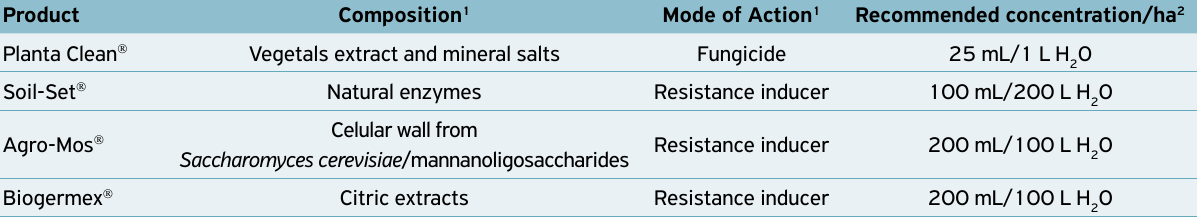
Table 1. Alternate phytosanitary products, mode of action and recommended concentration, used to evaluate the effect of the products on the development and silk production of B. mori